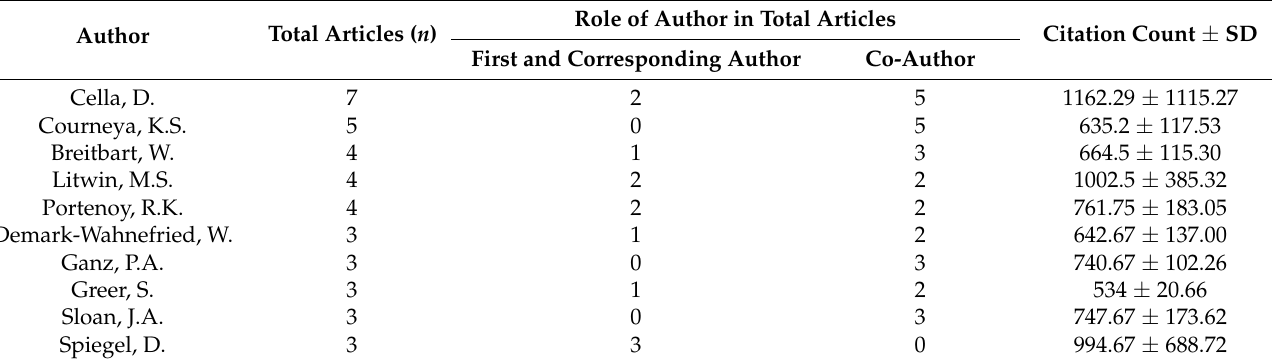
Table 4. Authors who contributed three or more of the 100 most-cited psycho-oncology